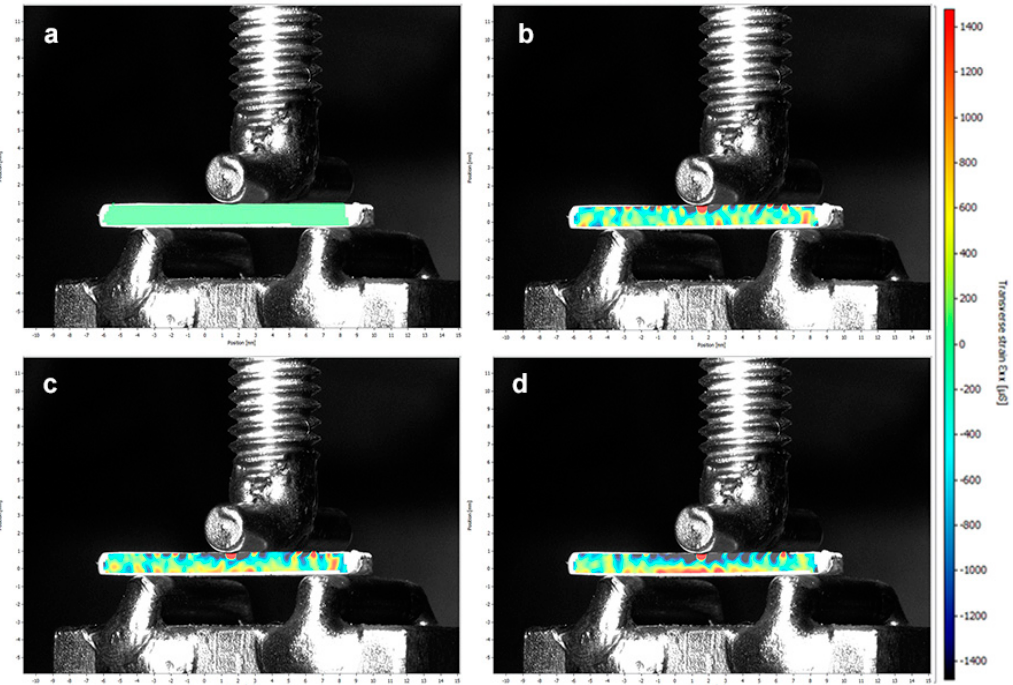
Figure 3. The sequence of photographs obtained in the DIC analysis of the material VE: ( a ) without strain concentration; ( b ) when the test starts; ( c ) with more load on specimen the strain concentration increases; and ( d ) the last photograph before failure.